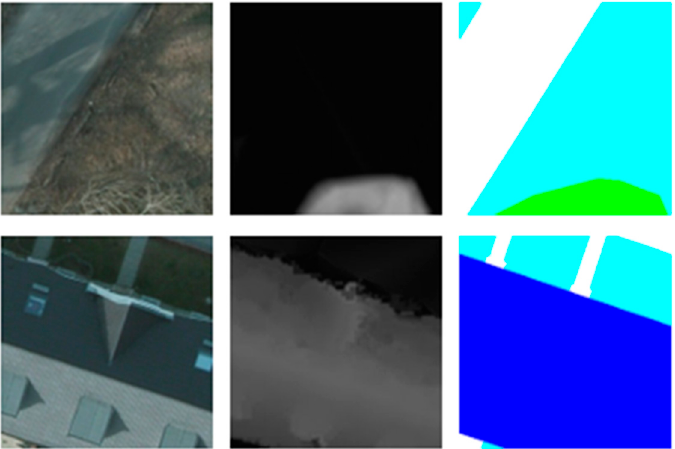
Figure 1. RGB image on the left, DSM image in the middle, the label image on the right.